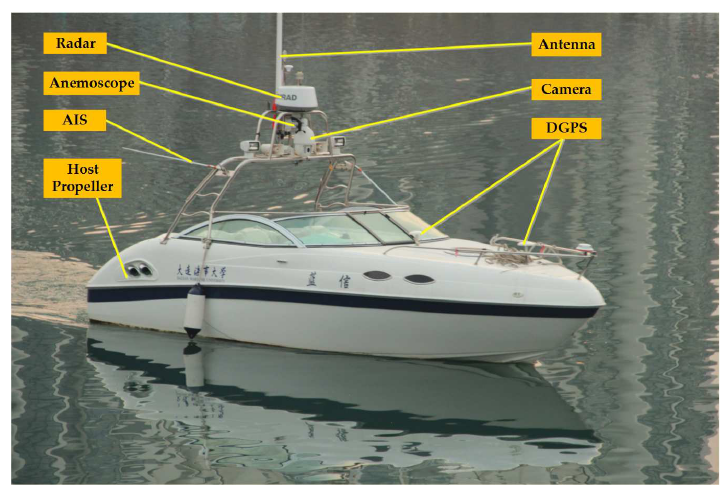
Figure 1. The Lanxin USV. AIS, automatic identification system.